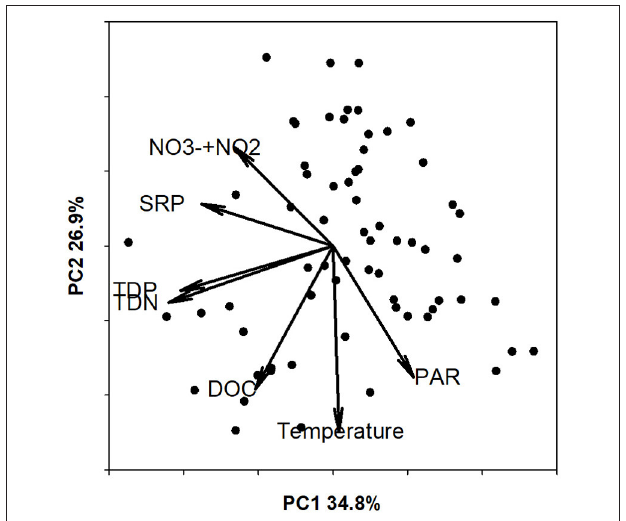
FIGURE 5 | Biplot of environmental characteristics with principal component 1 (PC1) on the x -axis and principle component 2 (PC2) on the y -axis. Points represent each sampling date and the vectors reflect the loading of each environmental variable on the PCA axes. Loadings for each PCA component are reported in Supplementary Table S1